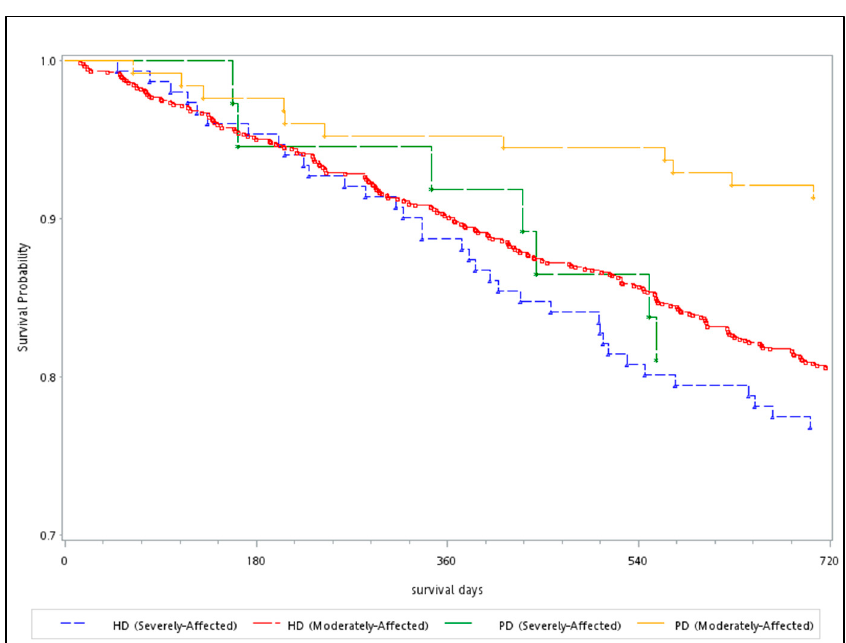
Figure 2. Survival analysis of adults with ESRD living in areas affected to different degrees by Ty- phoon Morakot. Typhoon